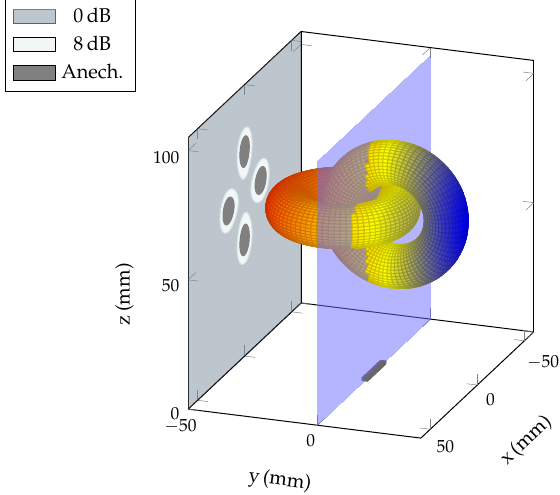
Figure 3. 3D schematic representation of the proposed